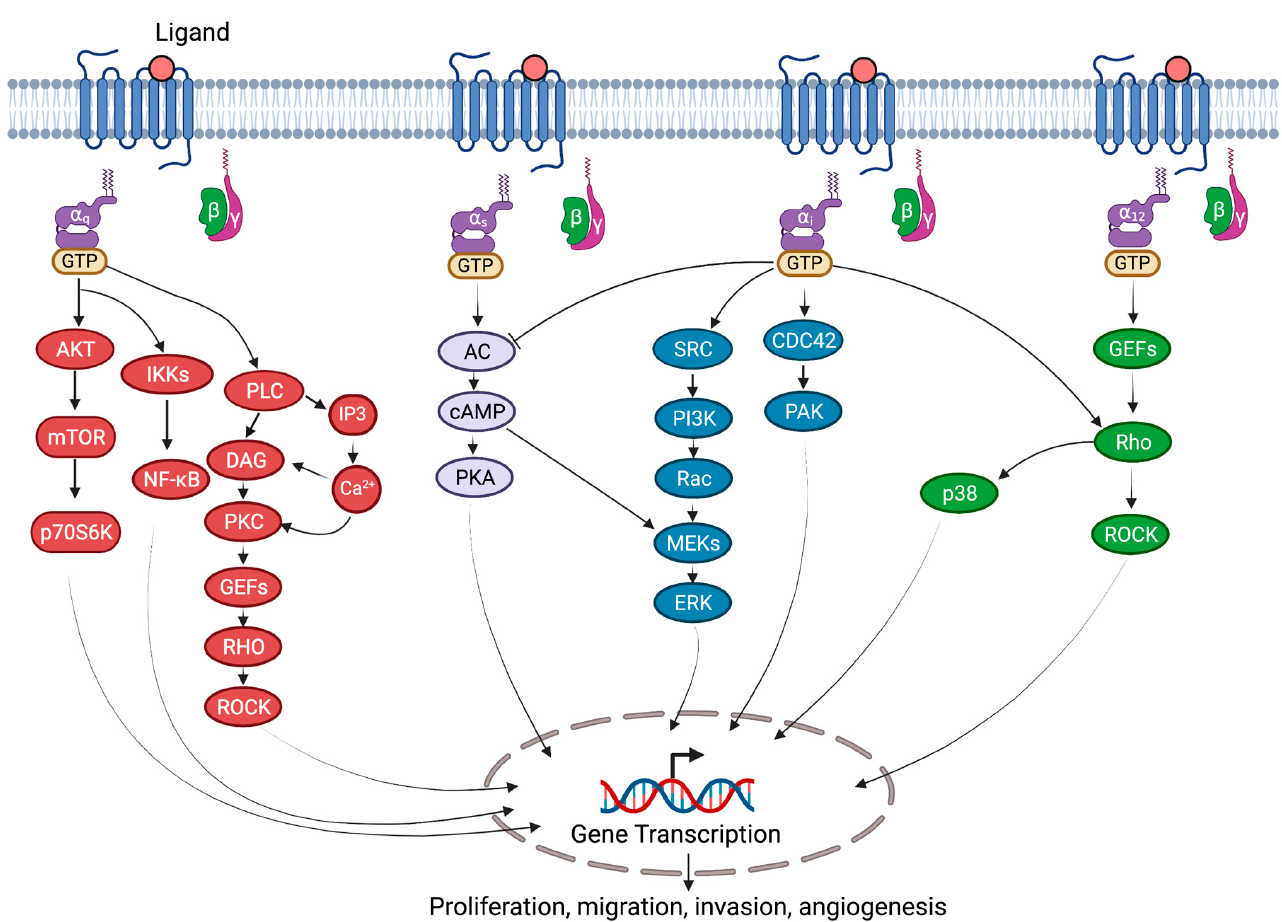
Figure 2. G-protein-coupled signaling in cardiovascular diseases. Various G-proteins, G α s, G α i, G α q, and G α 12/13, activate several downstream diverse signal transduction pathways. G α s proteins stimulate AC-cAMP-mediated activation of ERK and PKA signaling. G α q activates phospholipase C (PLC), which cleaves phosphatidylinositol-4,5-bisphosphate (PIP2) into diacyl glycerol (DAG) and inositol 1,4,5-trisphosphate (IP3), which leads to calcium mobilization and protein kinase C (PKC) activation. Furthermore, PKC activation induces Rho guanine nucleotide exchange factors (RhoGEFs) and mitogen-activated protein kinase (MAPK) signaling. G α q also activates AKT-mTOR and NF- κ B signaling pathways. G α i activates SRC-PI3K-RAC-MEK-ERK and CDC42-PAK signaling. G α 12/13 activate RhoGEFs-RHO-dependent p38 MAPK and ROCK signaling. AC, adenylyl cyclase; CDC42, cell division cycle 42; cAMP, cyclic AMP; ERK, extracellular signal-regulated kinase; IKKs, I κ B kinases; mTOR, mammalian target of rapamycin; p70S6K, ribosomal protein S6 kinase; NF- κ B, nuclear factor- κ B; PKA, protein kinase A; PAK, p21/CDC42/RAC1-activated kinase; ROCK, Rho-associated coiled-coil containing protein kinase; Rho, RAS homology.